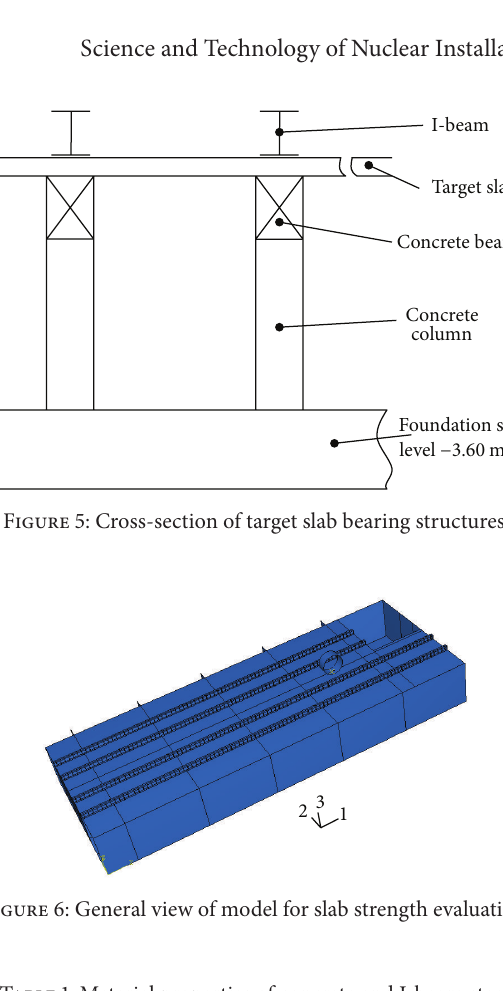
Table 1: Material properties of concrete and I-beam